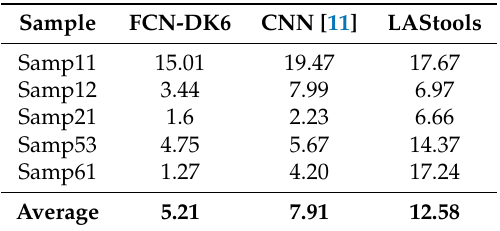
Table 2. Total error on ISPRS dataset.